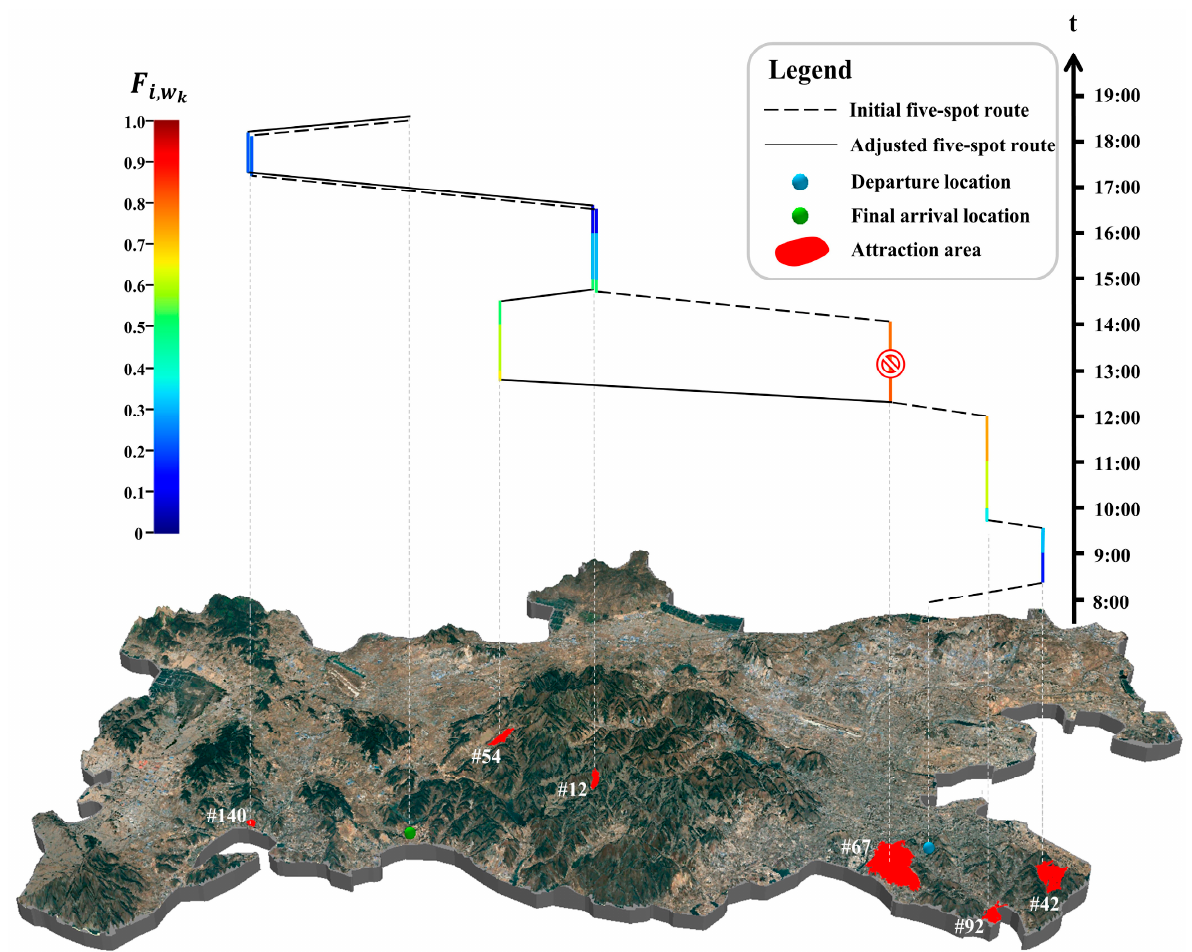
Figure 10. Routes before and after the dynamic adjustment.